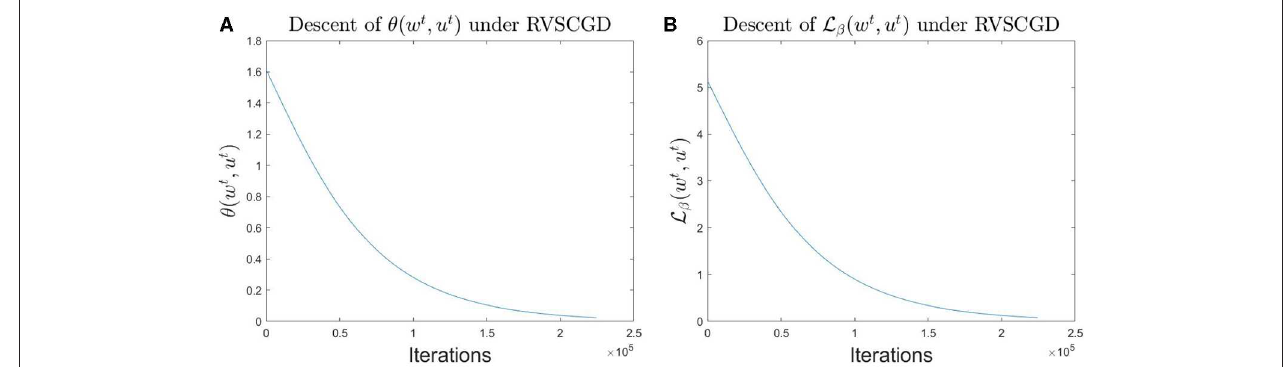
FIGURE 4 | Behavior of θ ( w t , w ∗ ) and L β ( w t , u t ) on the one-layer non-overlap network.